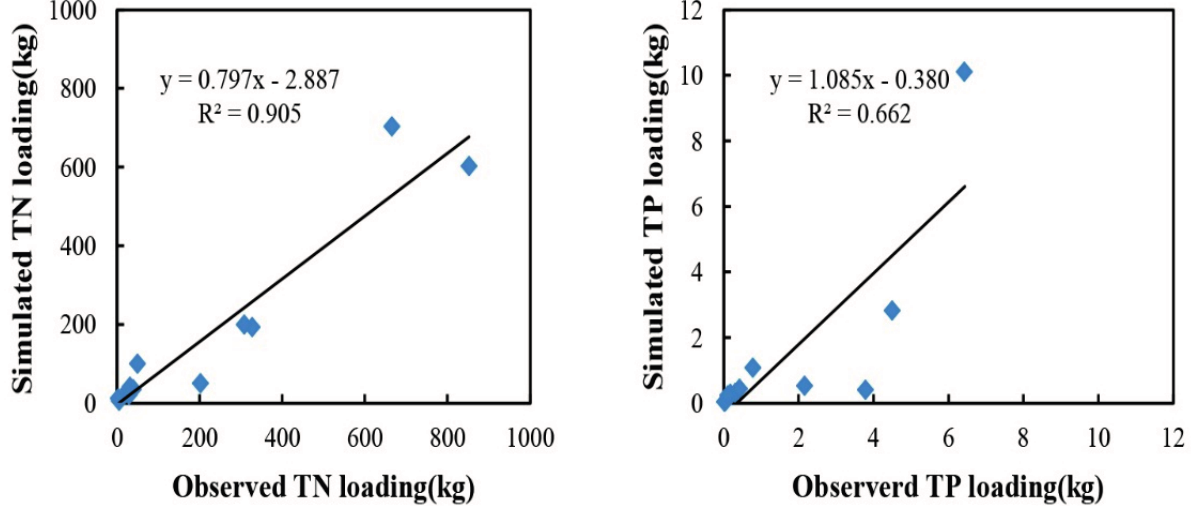
Figure 7. Comparison between observed and simulated TN ( left ) and TP ( right ) loading during the calibration